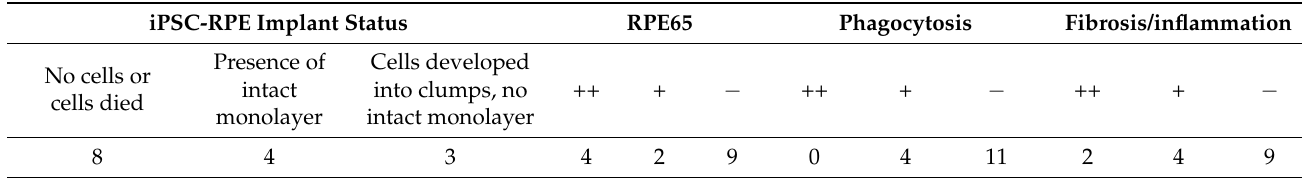
Figure 3. Representative HE and immunostaining images of immunodeficient RCS rats implanted with iPSC-RPE monolayer assessed at 11 months post implantation. Large white arrows ( a , d ) point to the parylene membrane. ( a – c ) Retina containing iPSC-RPE monolayer, ( d – f ) retina with iPSC-RPE appeared as multiple cell layers or cell clumps. TRA-1-85 white triangle in ( b , e ) and RPE65 expression were used for identifying iPSC-RPE. Absence of Ki67 expression indicates absence of proliferative cells ( b , e ). Rhodopsin immunostaining is used to identify photoreceptor survival yellow arrows in figure ( c , f ). Rhodopsin-containing phagosomes are found in the transplanted iPSC-RPE denoted by white arrows ( c , f ). Phagocytic activities were prominent in eyes in which monolayer structure was better preserved ( c ). Table 2. Summary of the histological result for iPSC-RPE implantation in immunodeficient RCS rats (11-month post